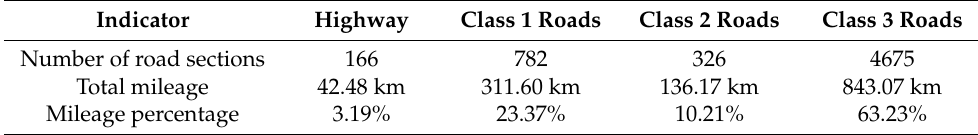
Figure 11. Statistics of urban road classification in Futian District. Table 6. Statistics of roads at all levels in Futian District, Shenzhen.